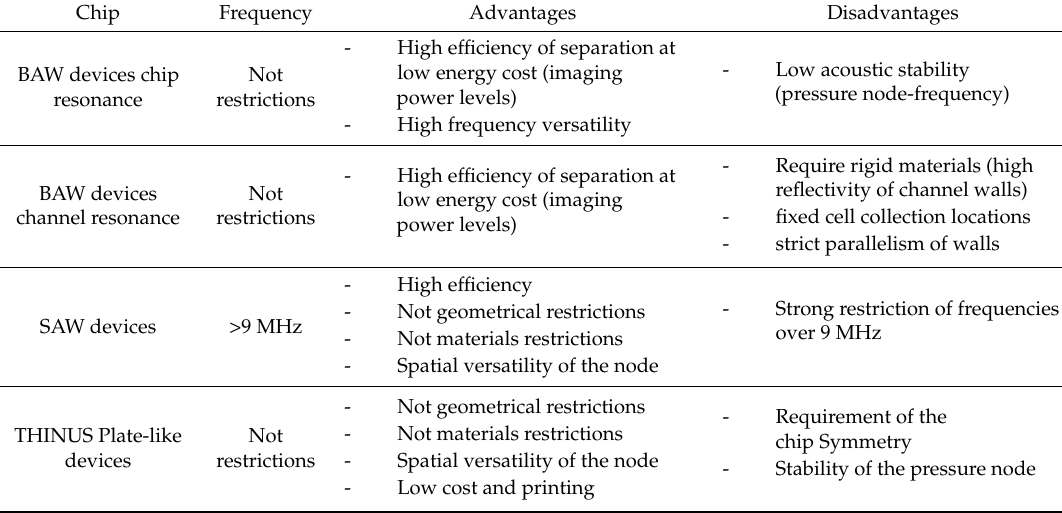
Table 2. Comparison of properties of BAW, SAW and PAW microfluidic devices to perform cell